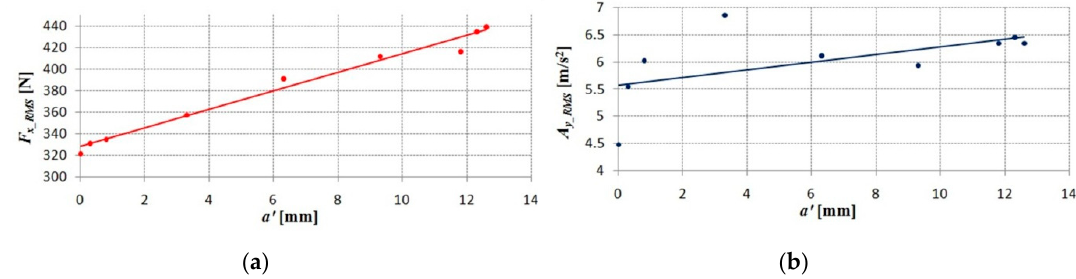
Figure 4. The root mean square values: ( a ) The root mean square values of cutting force F x force as function of а ′ ; ( b ) the root mean square values of acceleration of vibration A x as a function of а ′ .